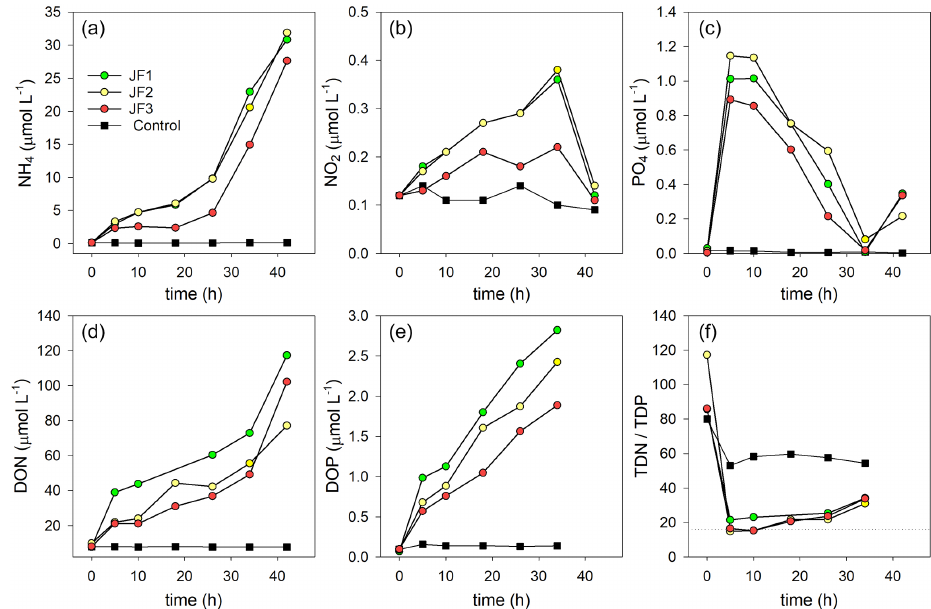
Figure 4. Changes in the concentrations (µmolL − 1 ) of organic and inorganic nutrients in the experimental cylinders enriched with carcasses of the jellyfish R. nomadica and in the controls: (a) ammonium, (b) nitrite, (c) orthophosphate, (d) DON, (e) DOP, and (f) TDN : TDP ratio. ( N =